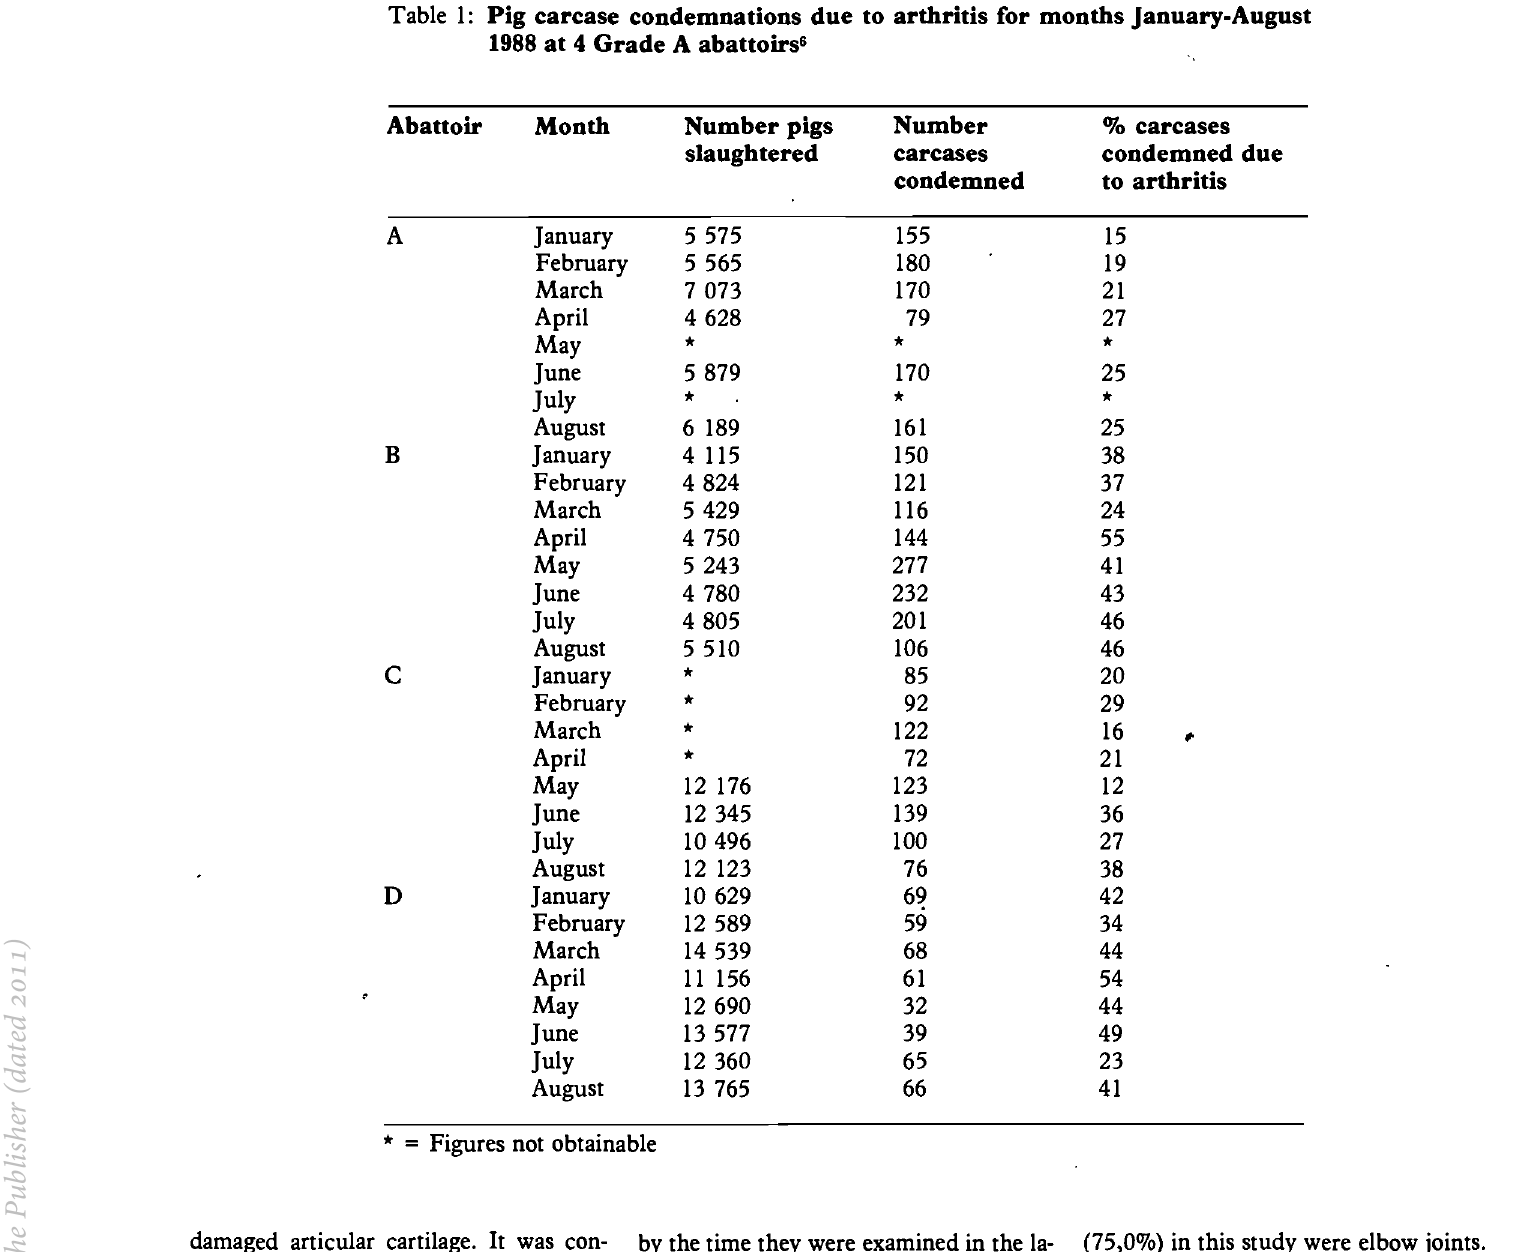
Table 1: Pig carcase condemnations due to arthritis for months